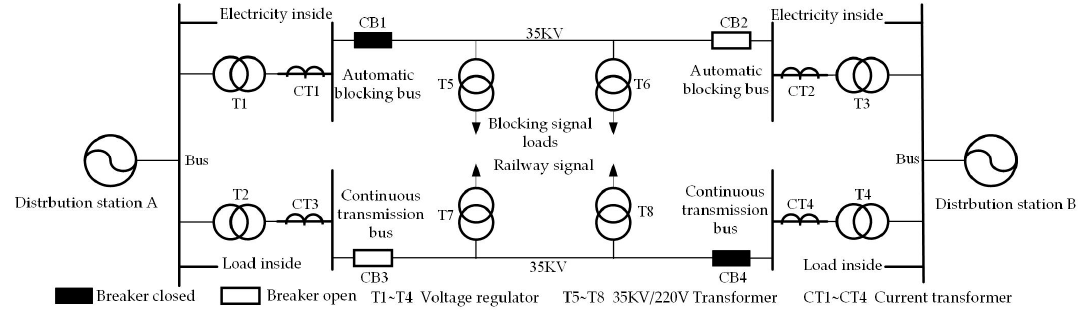
Figure 1. Diagram of automatic blocking and continuous transmission lines.